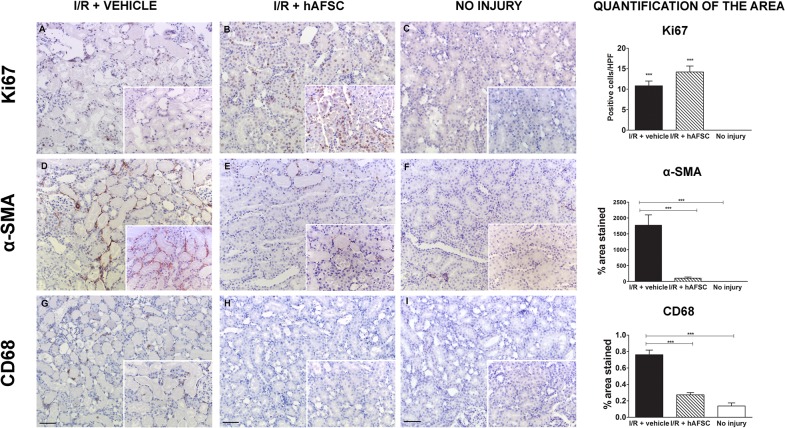
Enhancement of cell proliferation and decrease of myofibroblast differentiation, inflammation and fibrosis after stem cell therapy on acute kidney ischemia and reperfusion injury.Immunohistochemical staining of representative kidney sections from different experimental groups for proliferation (Ki67, Panel A-C), myofibroblast differentiation (α-SMA, Panel D-F) and macrophage infiltration (CD68, Panel G-I) at 48 hours after injury (scale bar = 20 μm). Quantitative analysis of the presence of the representative markers are depicted on the right for the three cohorts (vehicle treated (black), hAFSC treated (striped) and no injury (white)). * p<0.05, ** p<0.01, *** p<0.001 (scale bar = 50 μm).